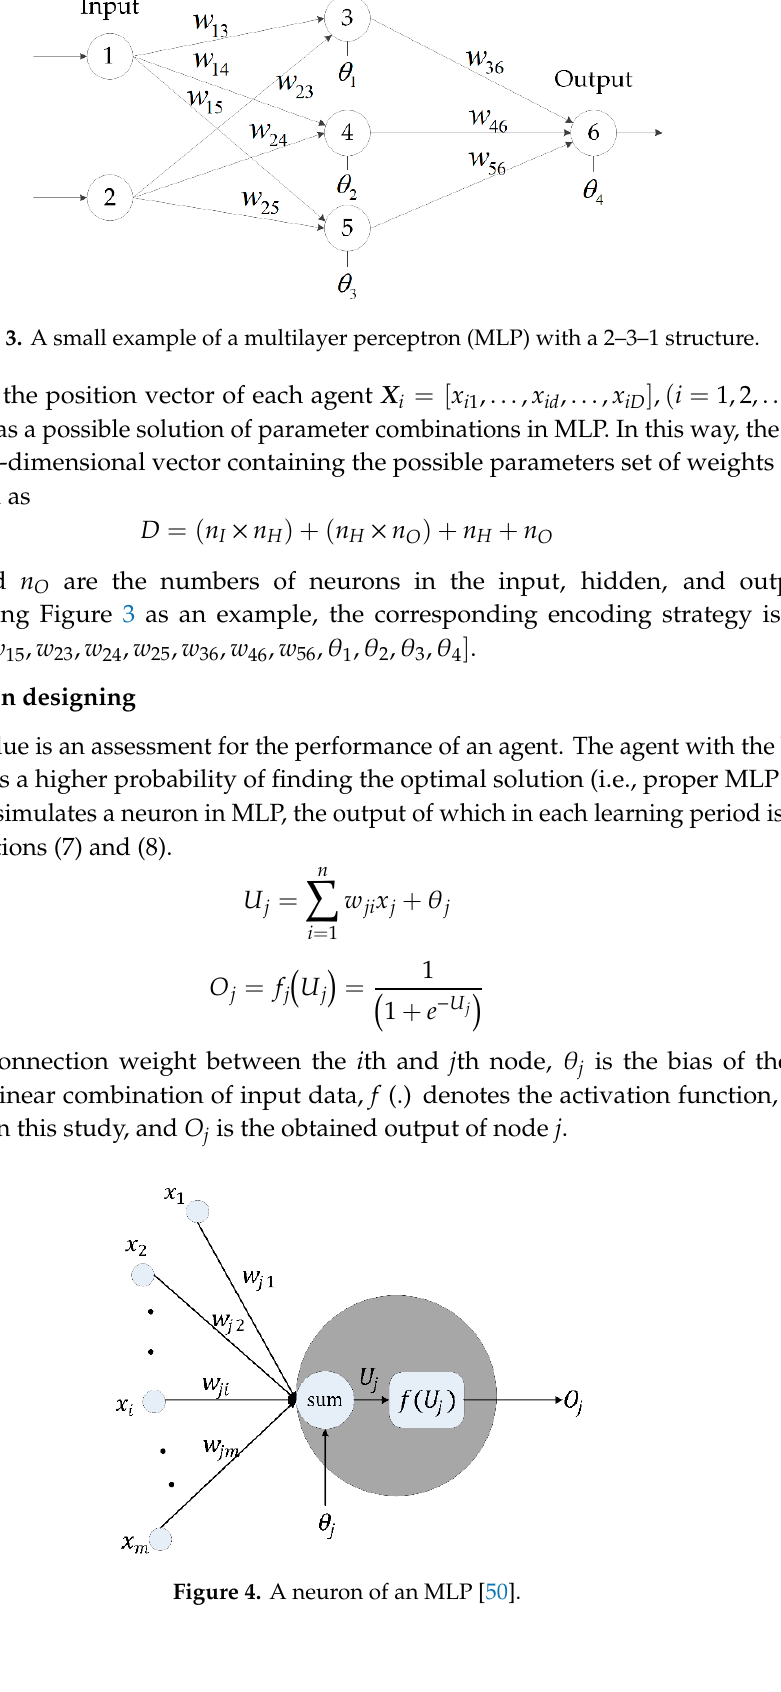
Figure 3. A small example of a multilayer perceptron (MLP) with a 2–3–1 structure.